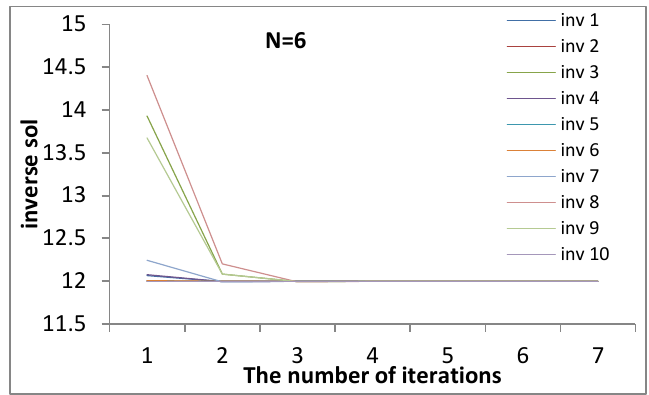
Figure 6. The inverse convergence curve of IABC colony, N = 6.